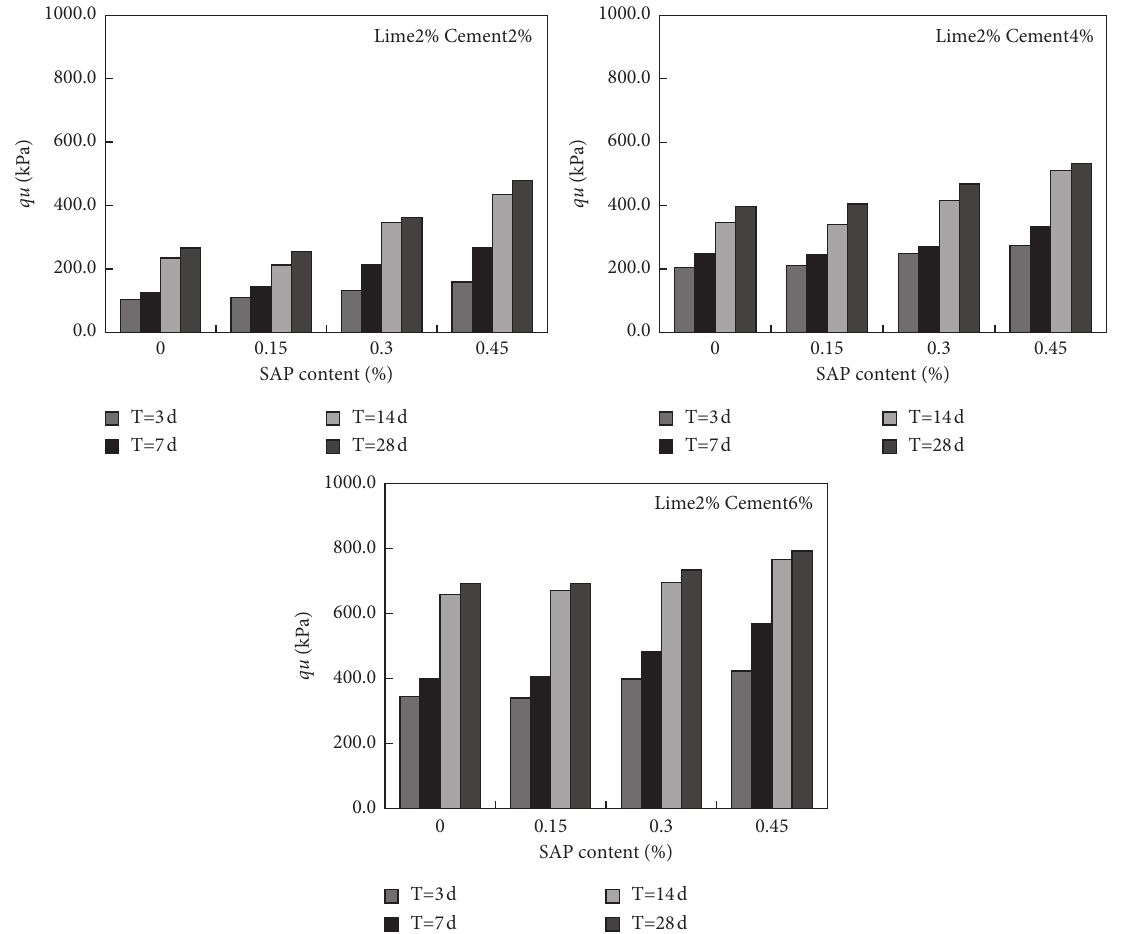
Figure 1: Effect of SAP content on q